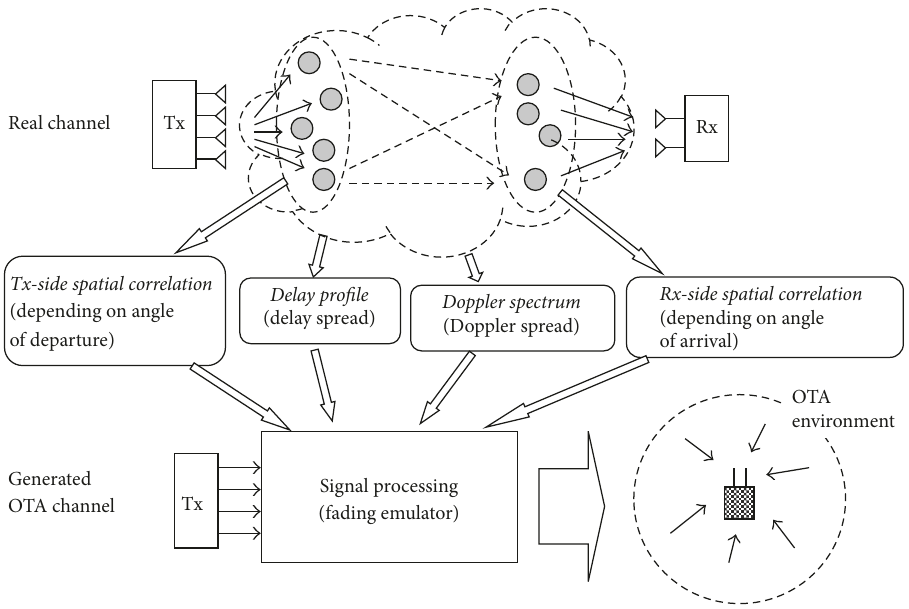
Figure 1: Triply selective multipath environment and its